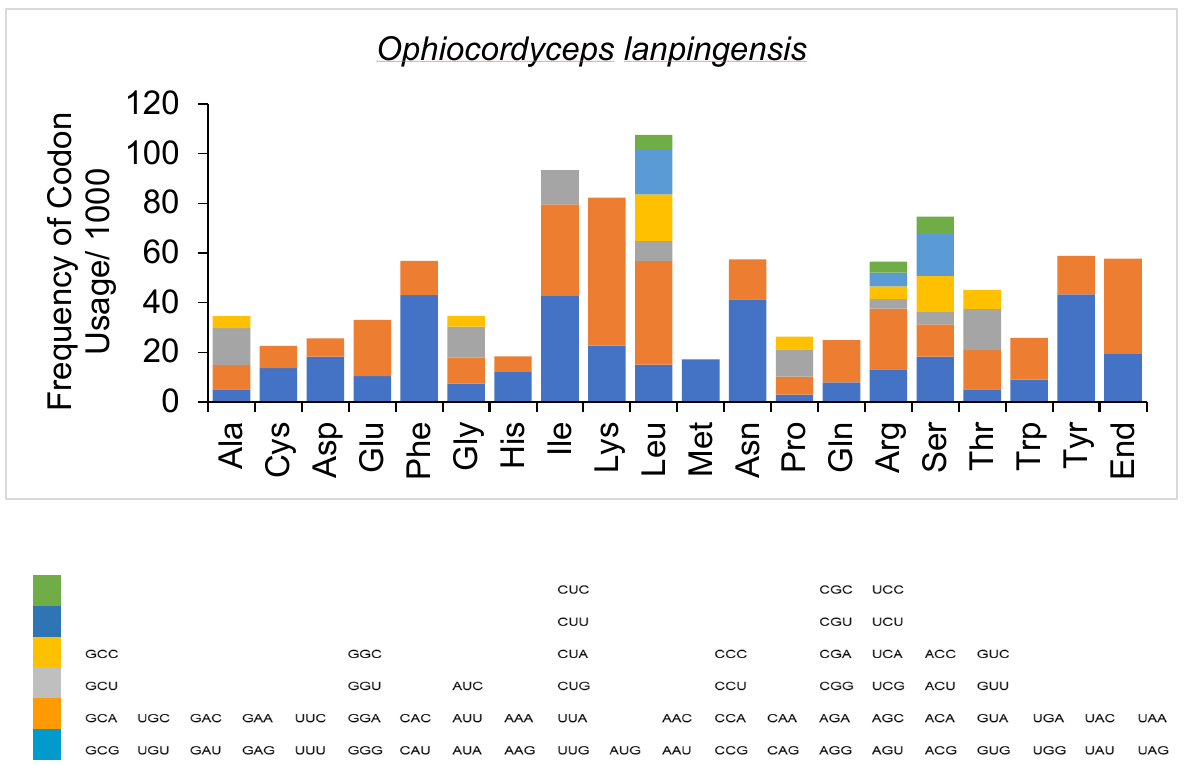
Figure 3. Codon usage analysis of the mitogenome of O. lanpingensis . The frequency of codon usage is plotted on the y axis. Table 5. tRNAs in the mitogenome of O.